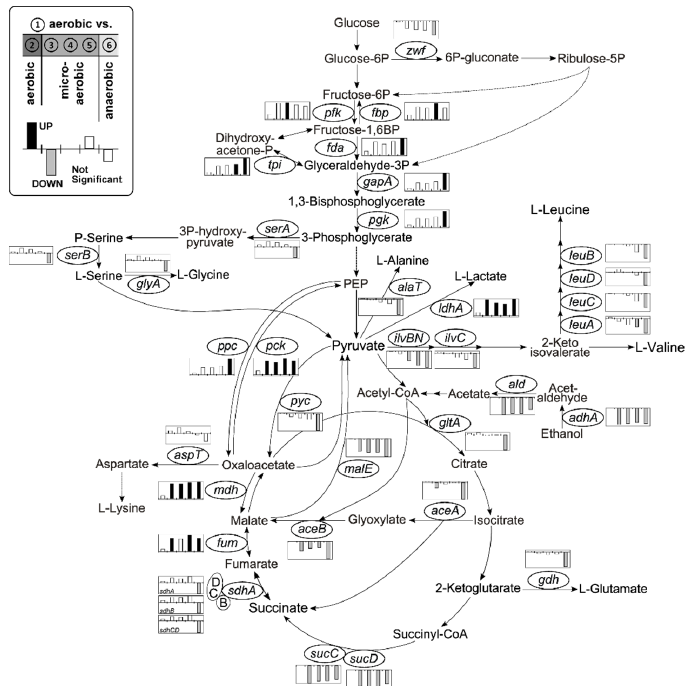
Figure 3. Transcriptional response to a shift from aerobiosis via microaerobiosis to anaerobiosis including genes of glycolysis, tricarboxylic acid cycle (TCA), glyoxylate shunt, oxidative pentose phosphate pathway and selected amino acid biosynthesis pathways. Column graphs represent log 2 -fold changes of enhanced (black) and reduced (grey) expression. Values outside the significance constraints ( m -value > 1.50, < − 1.50 and a -value > 1.00) are also shown (white). From left to right aerobiosis ( ② ), microaerobiosis ( ③ , ④ , ⑤ ) and anaerobiosis ( ⑥ ) versus the aerobic reference ( ① ; Figure 1A). Abbreviations of the given genes: aceA (isocitrate lyase), aceB (malate synthase), adhA